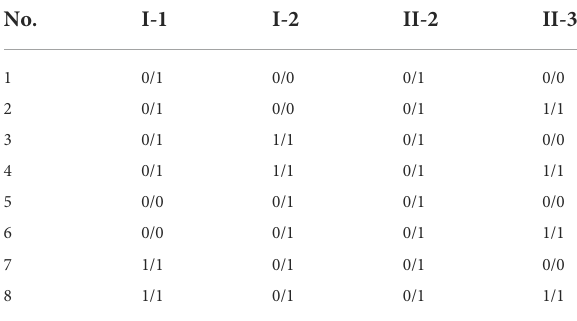
TABLE 1 Paternal informative SNP selection for haplotype